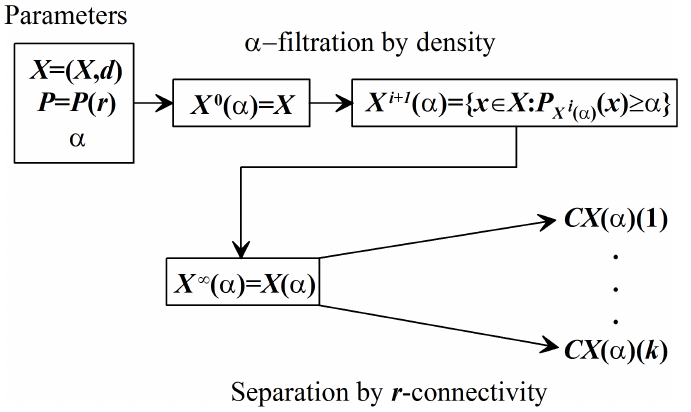
Figure 4. Block diagram of the